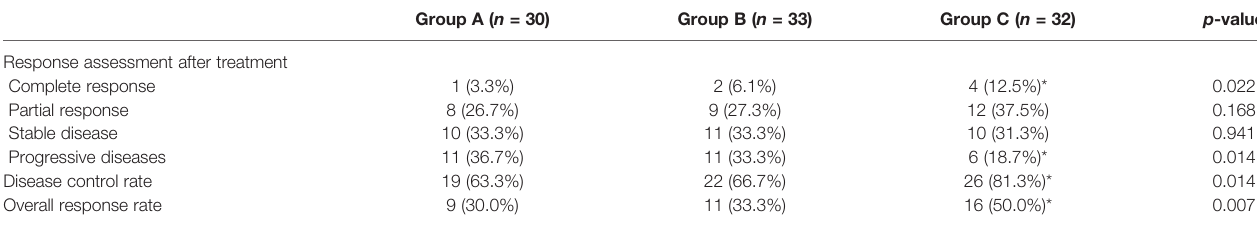
TABLE 2 | Short-term outcomes of H101, chemotherapy, and H101 combined with chemotherapy for advanced gastric carcinoma. Group A ( n = 30) Group B ( n = 33) Group C ( n = 32) p -value Response assessment after treatment Complete